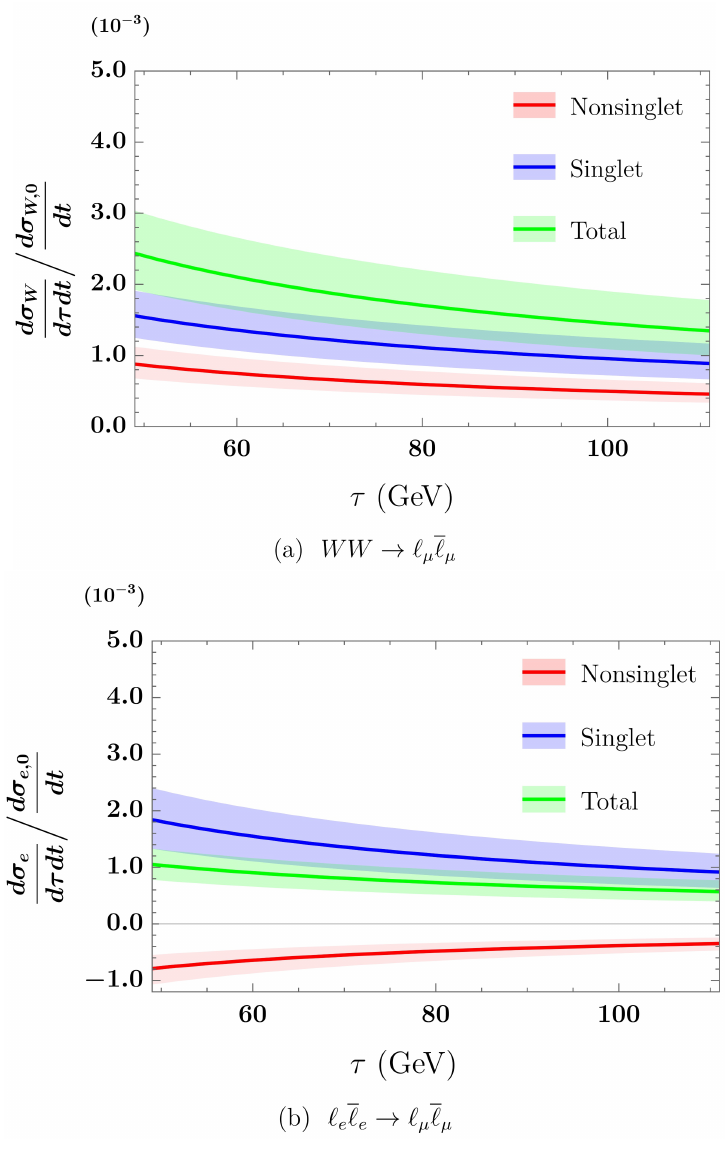
Figure 3 . The contributions to the 2-jettiness at NLL from the singlet (blue), the nonsinglet (red), and the total (green) contributions in (a) WW → ‘ µ ‘ µ , (b) ‘ e ‘ e → µ − µ + near threshold. The bands show the theoretical